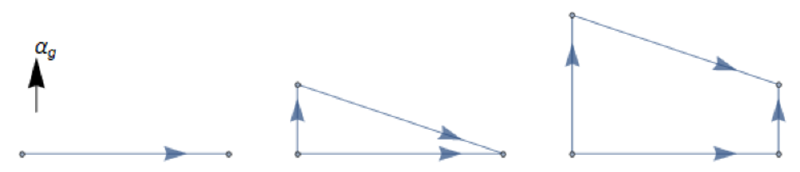
Figure 5. Topology of the RG-(cid:13)ow between 4 (cid:12)xed points in a group. Left (Large N): the 2 non-trivial (cid:12)xed points have (cid:11) g < 0. Middle (intemediate N): one of the non-trivial (cid:12)xed points has (cid:11) g > 0. Right (small N): both of the non-trivial (cid:12)xed points have (cid:11) g > 0. diverges for N c 16, while at N c = 1 the (cid:12)xed points will not exist for positive (cid:11) g . The (cid:21) last two (cid:12)xed points do not disappear through a saddle-node bifurcation, but will diverge in multiple couplings at small x